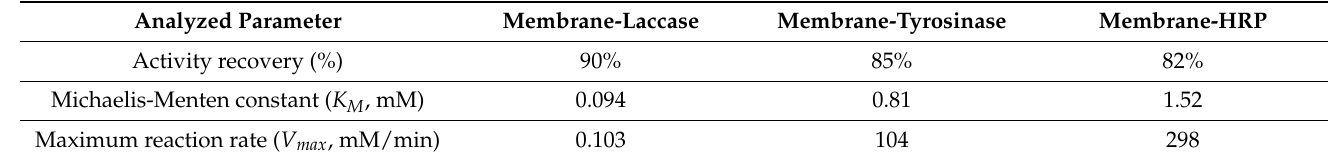
Table 2. Characterization of biocatalytic membranes produced in terms of activity recovery and kinetic parameters of free and immobilized enzymes. All values are presented as mean values, and which error value does not exceed